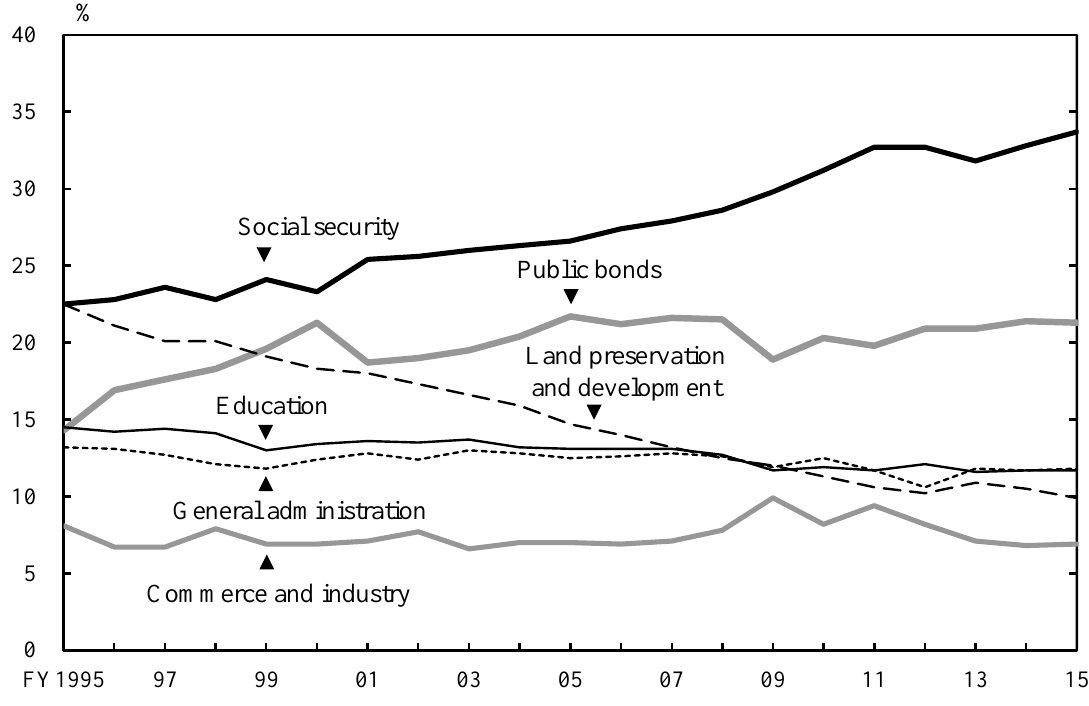
Figure 4.3 Ratio of Net Total National and Local Expenditures by